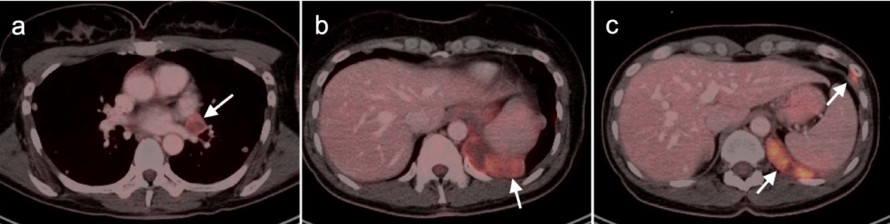
Figure 26. Primary synovial sarcoma of the pleura. ( a – c ) There are multiple hypermetabolic masses in the left pleural space shown on axial FDG PET-CT images of the chest (white arrows). No other sites of tumor were